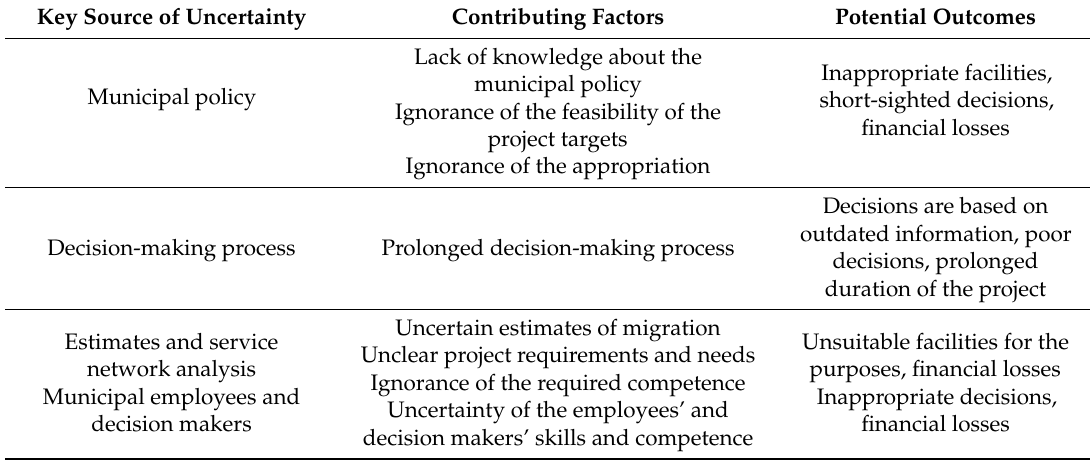
Table 5. The sources and the potential outcomes of the uncertainty concerning the operational environment. Key Source of